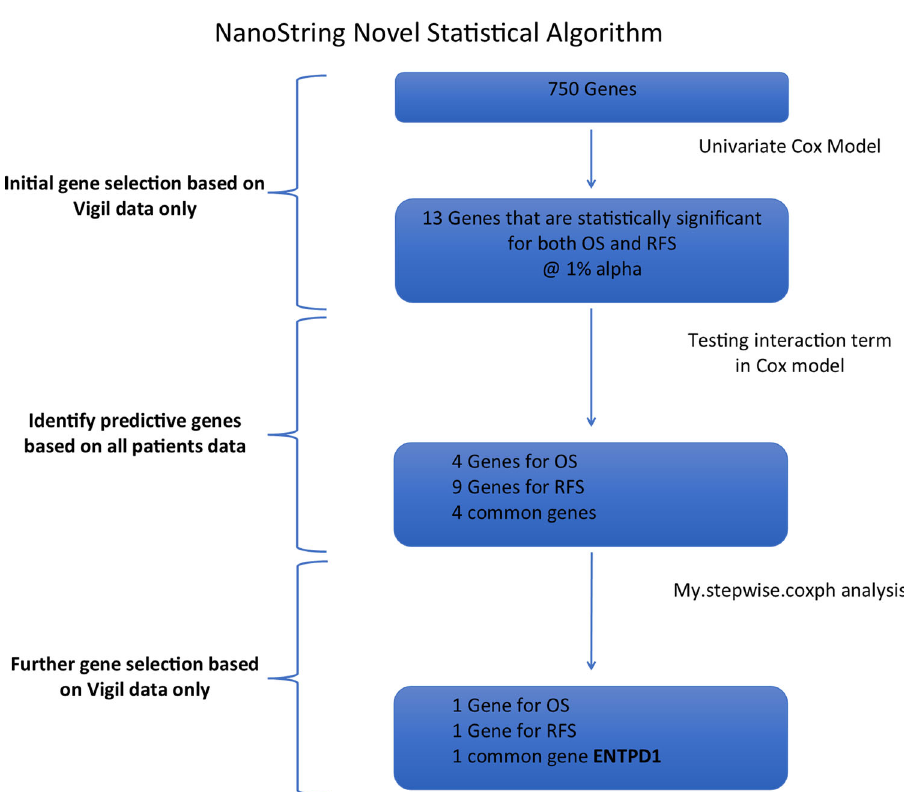
Fig. 2 NanoString Statistical Algorithm. Flow chart of all patients ’ analysis. Analyzed both with genes as raw continuous data and with genes dichotomized. Genes were selected if the interaction term was signi fi cant in both analyses. 5% alpha was used unless